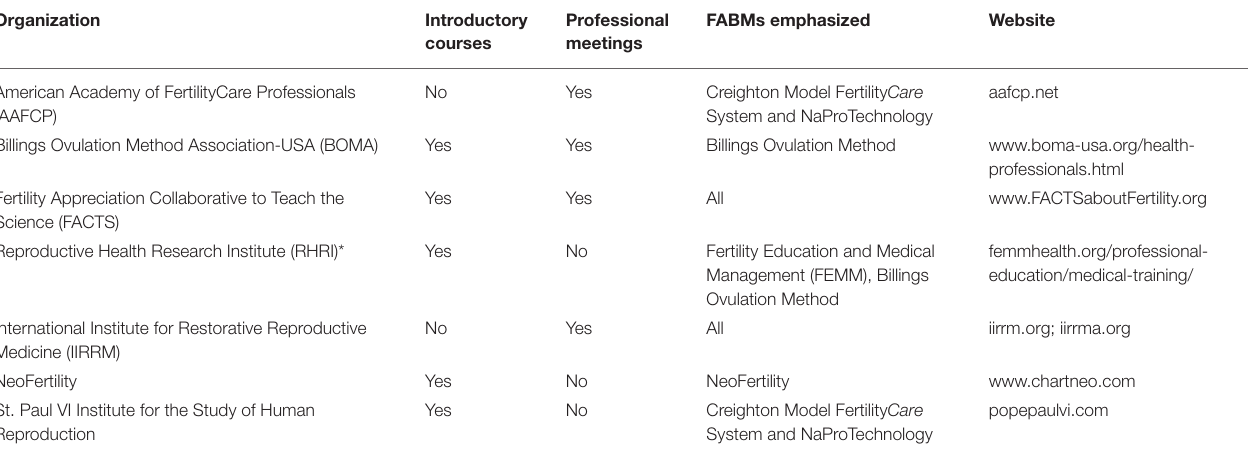
TABLE 3 | Continuing medical education (CME) resources for medical applications of fertility awareness-based